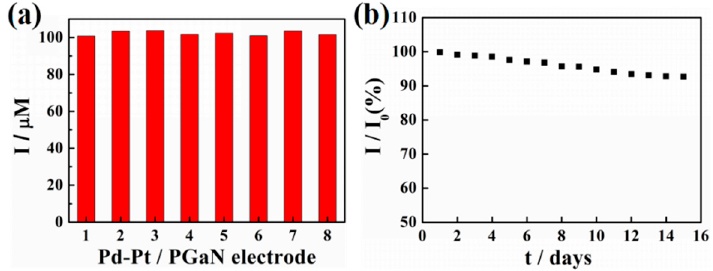
Figure 6. ( a ) Current responses of eight Pd-Pt/PGaN electrodes to 1 mM NaNO 2 in 0.1 M PBS. ( b ) The long-term stability of a Pd-Pt/PGaN electrode in 15